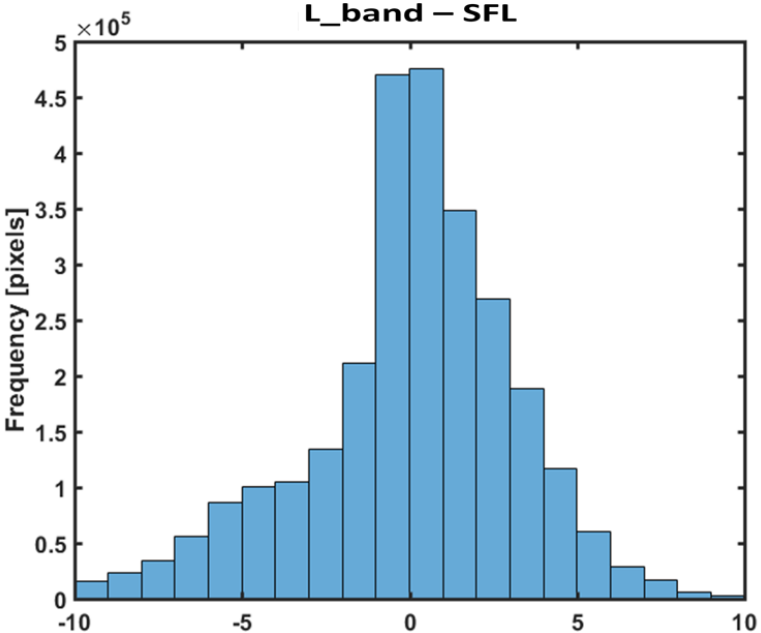
Figure 11. Histogram of the height difference (L_band—SFL Lidar